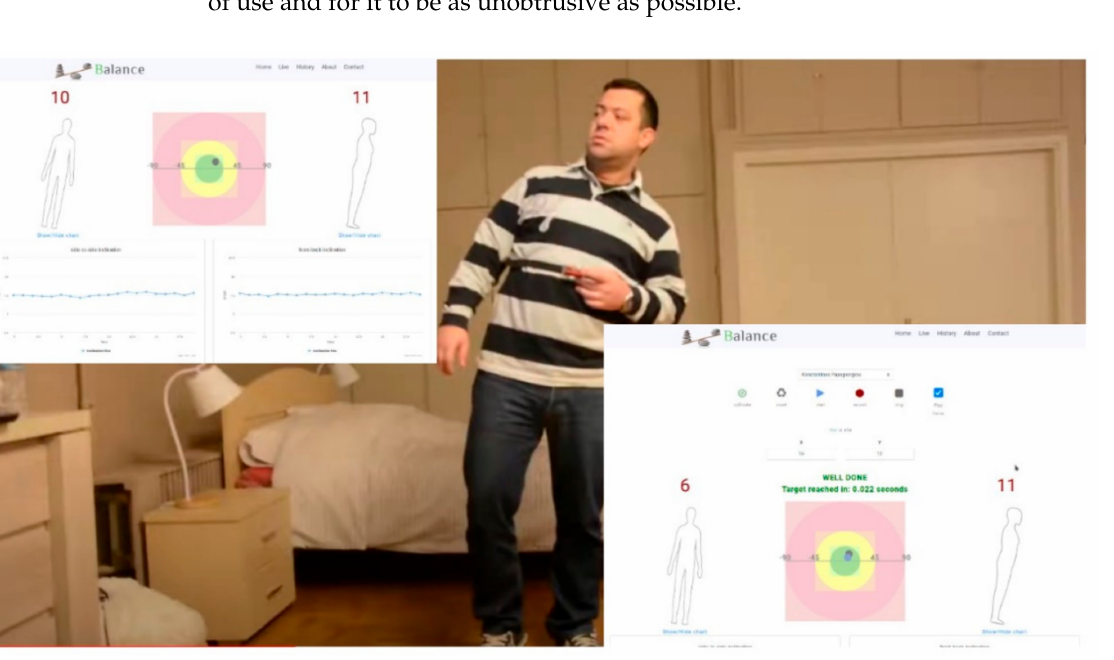
Figure 1. A-Balance in